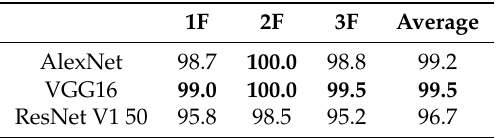
Table 4. Floor classification accuracy (%) with the three CNNs.